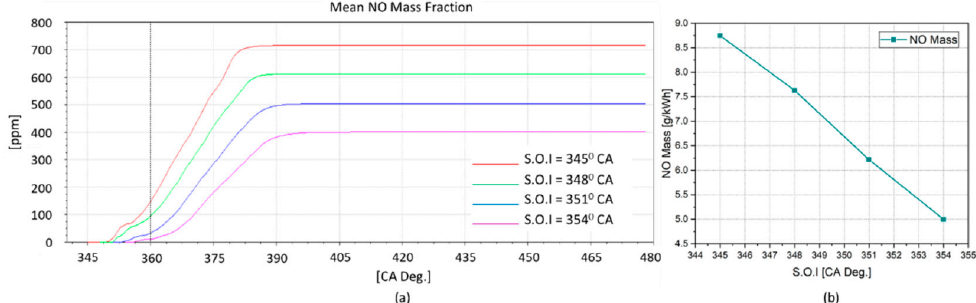
Figure 23. Mean NO mass fraction diagrams ( a ) and NO emission masses ( b ) according to the change of S.O.I angle in the diesel mode.